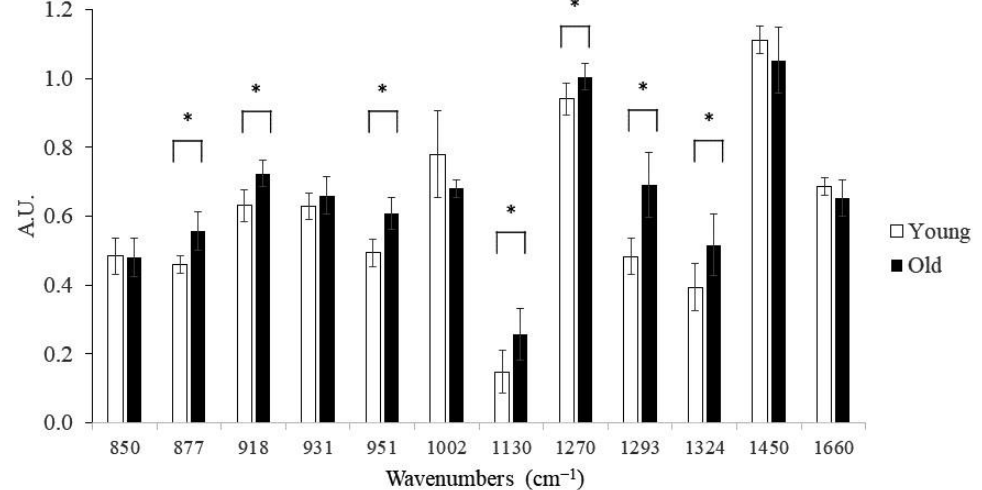
Figure 4. Group comparison between different Raman band intensities. Young group: n = 8 speci- mens, 10 spectra per specimen; Old group: n = 8 specimens, 10 spectra per specimen; *: p < 0.05. Table 1. Pearson’s correlation coefficients between Raman band intensities and biochemical assays of human Achilles and tibialis anterior tendons.